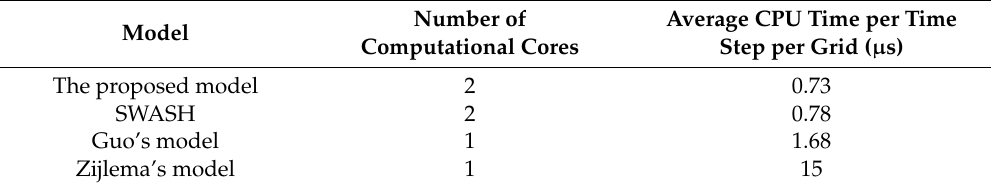
Table 2. Average CPU time per time step per grid of the four